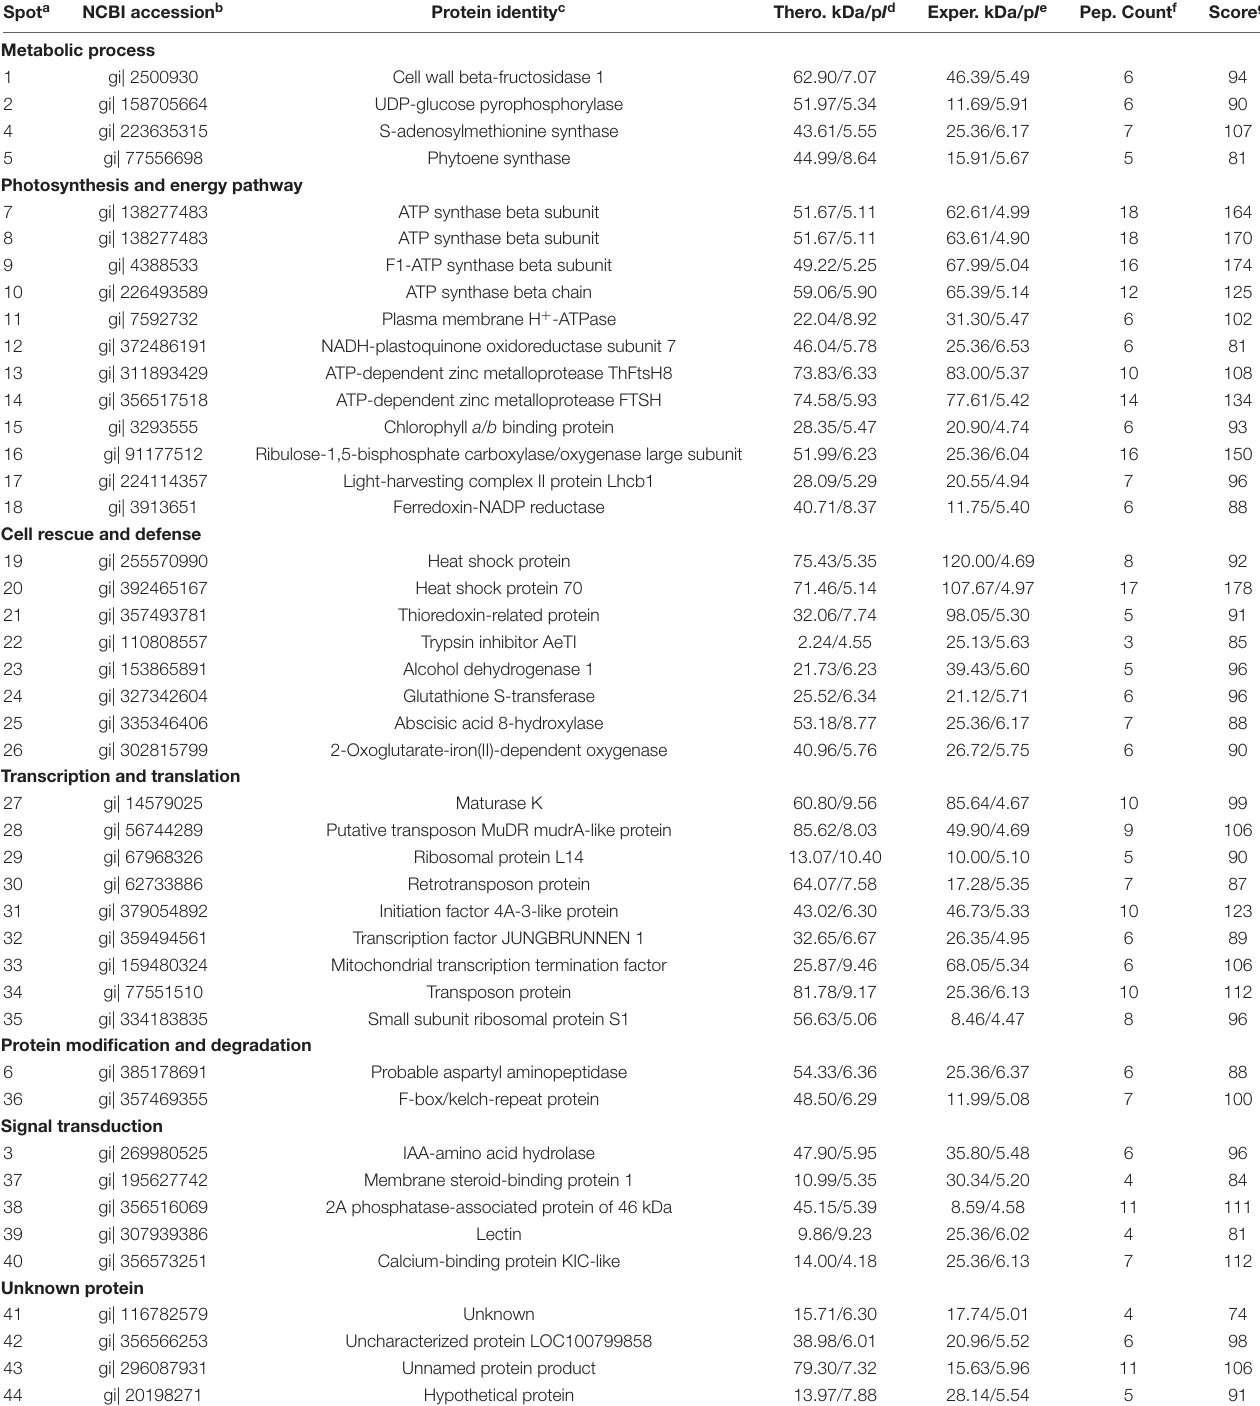
TABLE 1 | Differentially expressed proteins of Taxus wallichiana var. mairei in response to AR stress under different calcium levels. Spot a NCBI accession b Protein identity c Thero. kDa/p I d Exper. kDa/p I e Pep. Count